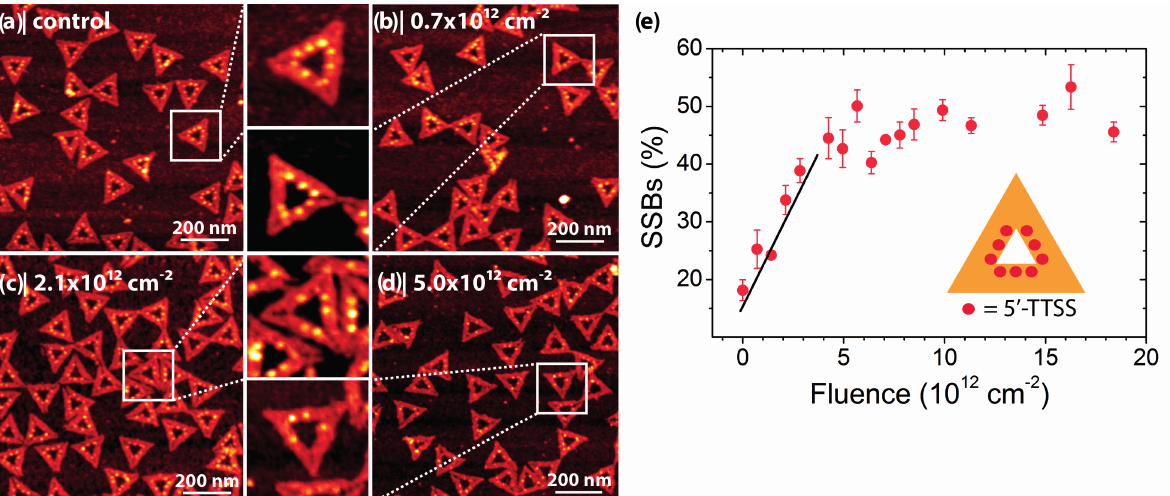
Figure 6. Irradiation of triangular DNA origami structures carrying nine disulfide-containing strands with 18 eV electrons [26]. ( a ) AFM image of a non-irradiated control sample. The sequence of the protruding strands is 5'-TTSS. The DNA origami structures were immobilized on silicon and exposed to SAv, which had a binding efficiency of 80%–90%; ( b – d ) AFM images of samples irradiated with different fluences of 18 eV electrons. Due to electron-induced bond cleavage in the protruding strands the number of specifically bound SAv decreases with electron fluence; ( e ) Plot of the relative number of strand breaks (in %) vs. electron fluence. The DNA origami design is shown in the inset of